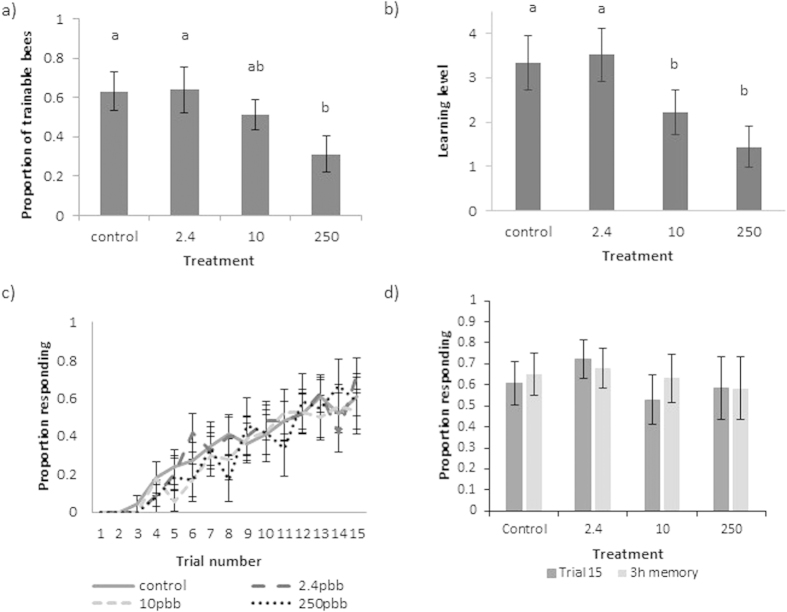
Results from experiment 1: acute exposure.(a) The mean proportion of bees in each acute treatment group that were trainable (trainability). (b) The mean number of conditioned responses of all acutely exposed bees per treatment group (learning level). (c) Acquisition curves showing the mean proportion of acutely exposed bees responding with a proboscis extension to the conditioned odour prior to reward over 15 conditioning trials. (d) Memory recall of the conditioned association (illustrated by mean proportion of bees that showed the conditioned response to the presented odour on trial 15 (dark grey bars) and 3 hours after the learning task in the memory test (light grey bars)) from trainable bees). Letters indicate significantly different pairwise comparisons from post-hoc tests (p < 0.05), and error bars indicate SE.